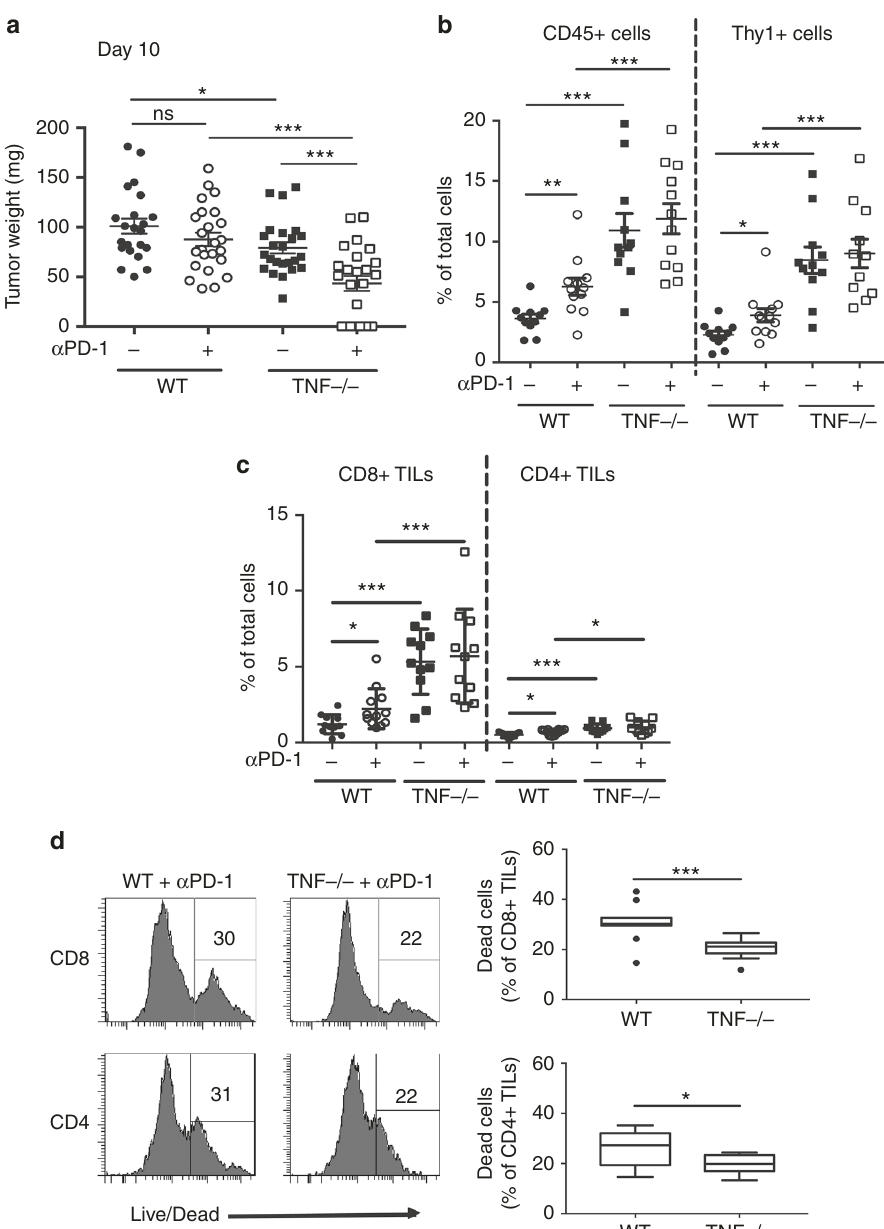
Fig. 2 Immune cell in fi ltration of tumors from anti-PD-1 treated wild-type and TNF-de fi cient mice with established melanoma. a – c , C57BL/6 wild-type (WT) and TNF-de fi cient (TNF − / − ) mice were intradermally and bilaterally grafted with 1 × 10 6 B16K1 melanoma cells prior to intraperitoneal injection of anti-PD-1 antibodies ( α PD-1, 10 mg kg − 1 ) or vehicle (PBS) at day 7. a At day 10, mice were sacri fi ced and tumors were weighed. Data are means ± s.e.m. of at least 22 tumors per group from two independent experiments (Student ’ s t -test: * p < 0.05; *** p < 0.001). b and c TIL content was analysed by fl ow cytometry. The proportion of CD45+ and Thy1+ cells ( b ) CD4+ and CD8+ TILs ( c ) among total cells was determined. Data are means ± s.e.m. of at least 11 tumors per group from two independent experiments (Mann – Whitney U test: * p < 0.05; ** p < 0.01; *** p < 0.001). d Proportion of dead CD8+ and CD4+ TILs from WT and TNF-de fi cient mice treated with anti-PD-1. Left panels: representative stainings. Right panels: values measured in 12 tumors per group from two independent experiments are represented as Tukey boxes (Student ’ s t -test: * p < 0.05; *** p < and b). TNF de fi ciency totally abrogated PD-L1 up-regulation on TILs independently of anti-PD-1 treatment (Supplementary TILs upon anti-PD-1 therapy (Supplementary Fig. 8a and b). We Fig. 7d). No difference in the proportion of IFN- γ + CD4+ TILs also monitored the tumor content of dendritic cells (DCs), which between anti-PD-1-treated WT and TNF-de fi cient mice was play a key role in the priming of T cells. Tumor-in fi ltrating DCs observed (data not shown). were slightly, yet signi fi cantly, increased in WT mice treated with TNF is known to promote PD-L1 expression in solid cancers 17 , including melanoma 15 . We thus analyzed PD-L1 and PD-L2 anti-PD-1 as well as in TNF-de fi cient mice with or without anti- levels under our experimental conditions. In WT mice, treatment PD-1 injection (Supplementary Fig. 8c). Moreover, the expression with anti-PD-1 selectively enhanced PD-L1, but not PD-L2, of PD-L1 and, albeit to a lesser extent, PD-L2 was reduced on expression by both CD4+ and CD8+ TILs (Supplementary Fig. 8a DCs in TNF-de fi cient mice under control and anti-PD-1